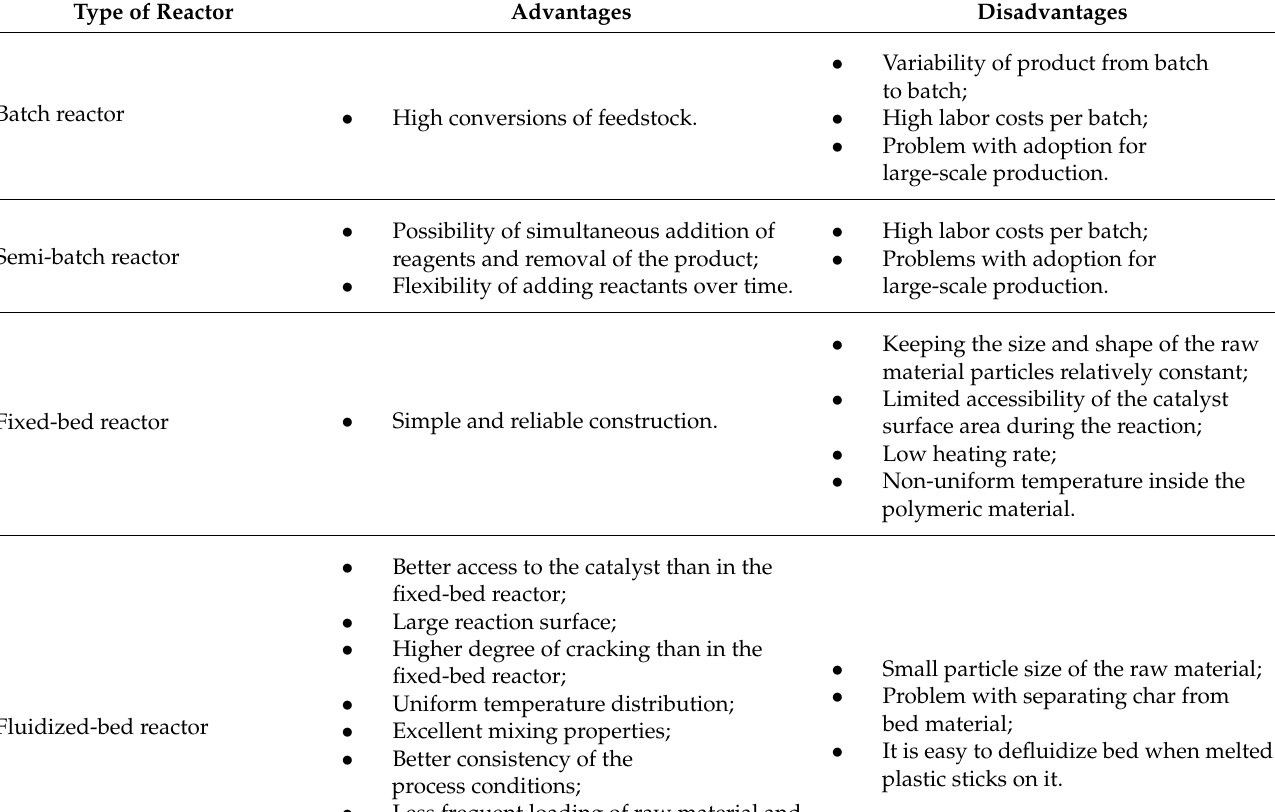
Table 2. The main advantages and disadvantages of pyrolysis reactors